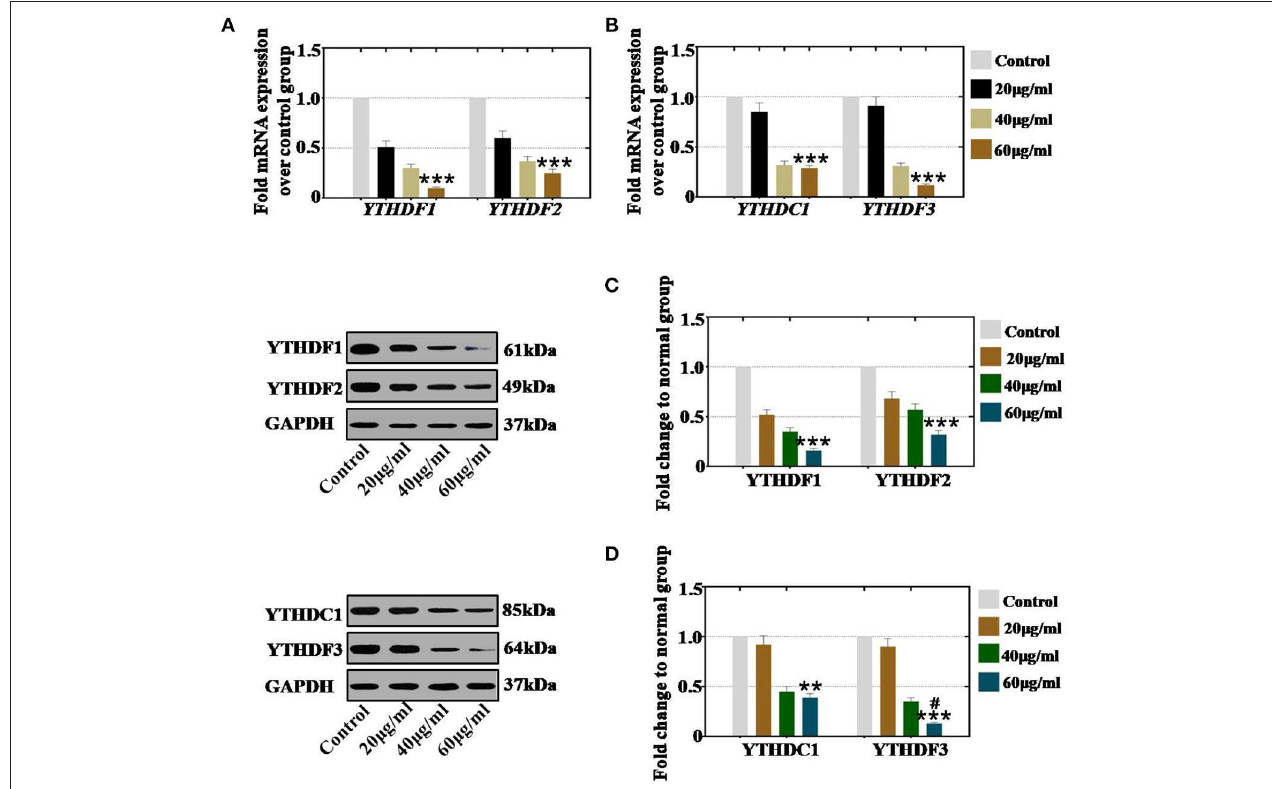
FIGURE 6 | Quantification and concentration-dependence analysis of the RNA effector expression levels after CTX treatment in vivo . (A) The mRNA expression levels of YTHDF1 and YTHDF2 in hGCs were measured after CTX treatment (20, 40, and 60 µ g/ml). (B) The mRNA expression levels of YTHDC1 and YTHDF3 in hGCs were measured after treatment with CTX (20, 40, and 60 µ g/ml). (C) The protein expression levels of YTHDF1 and YTHDF2 in hGCs were measured after treatment with CTX (20, 40, and 60 µ g/ml). (D) The protein expression levels of YTHDC1 and YTHDF3 in hGCs were measured after treatment with CTX (20, 40, and 60 µ g/ml). All experiments were performed three times. The error bars indicate SD; ** p < 0.01; *** p < 0.001 (compared with control group); # p < 0.05 (compared with the 40 µ g/ml CTX concentration group).